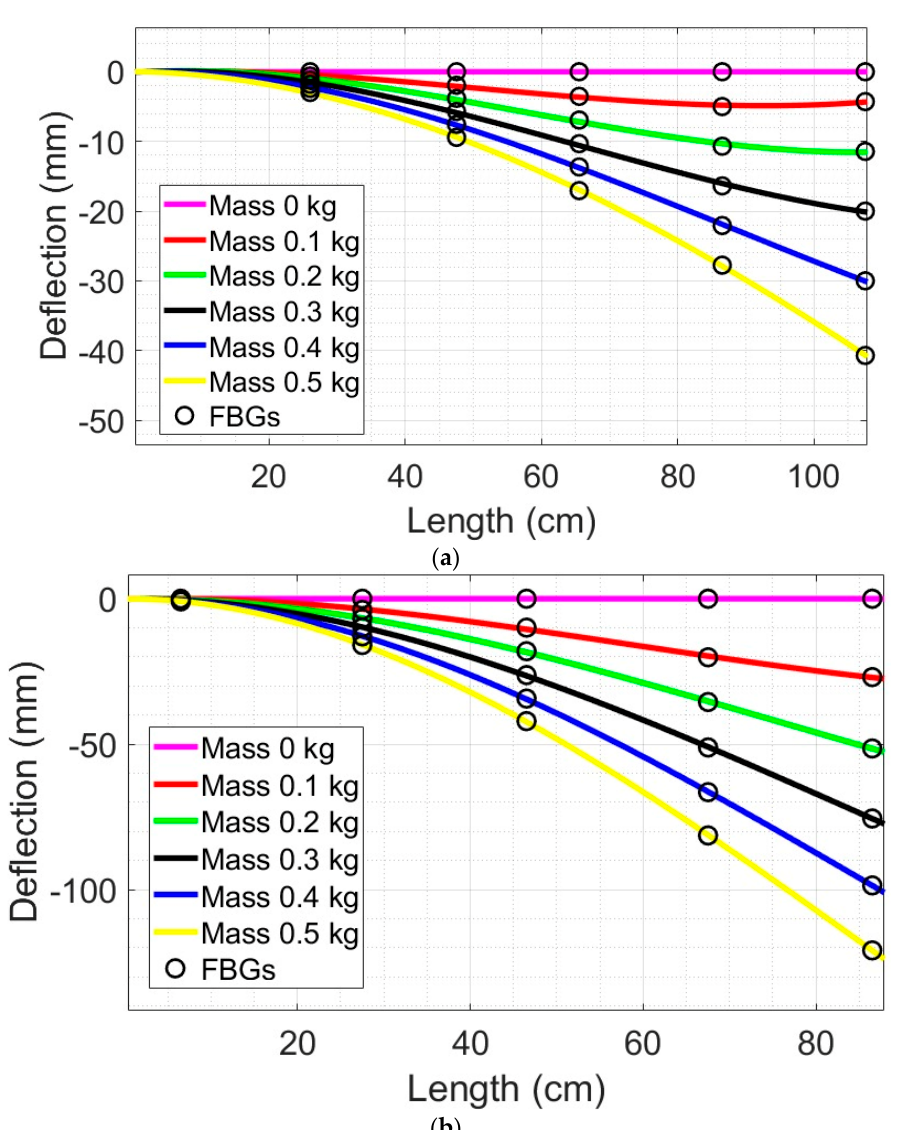
Figure 6. Elastic lines and 2D shape reconstruction at different load conditions for ( a ) Wooden beam; and ( b ) Nylon 6.0 beam.